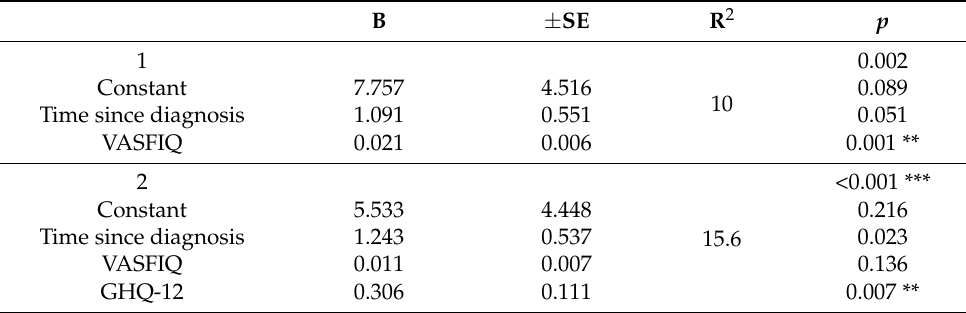
Table 3. Comparison of different models in predicting body-image scale